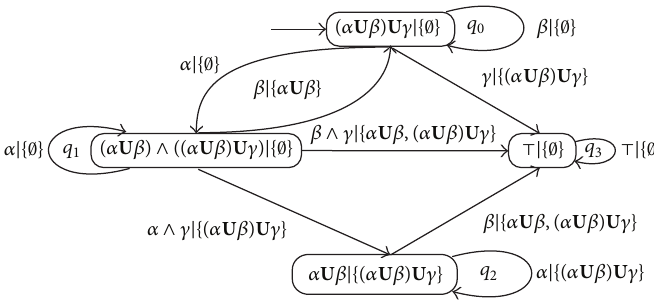
Figure 1: The expansion of (𝛼 U 𝛽) U 𝛾